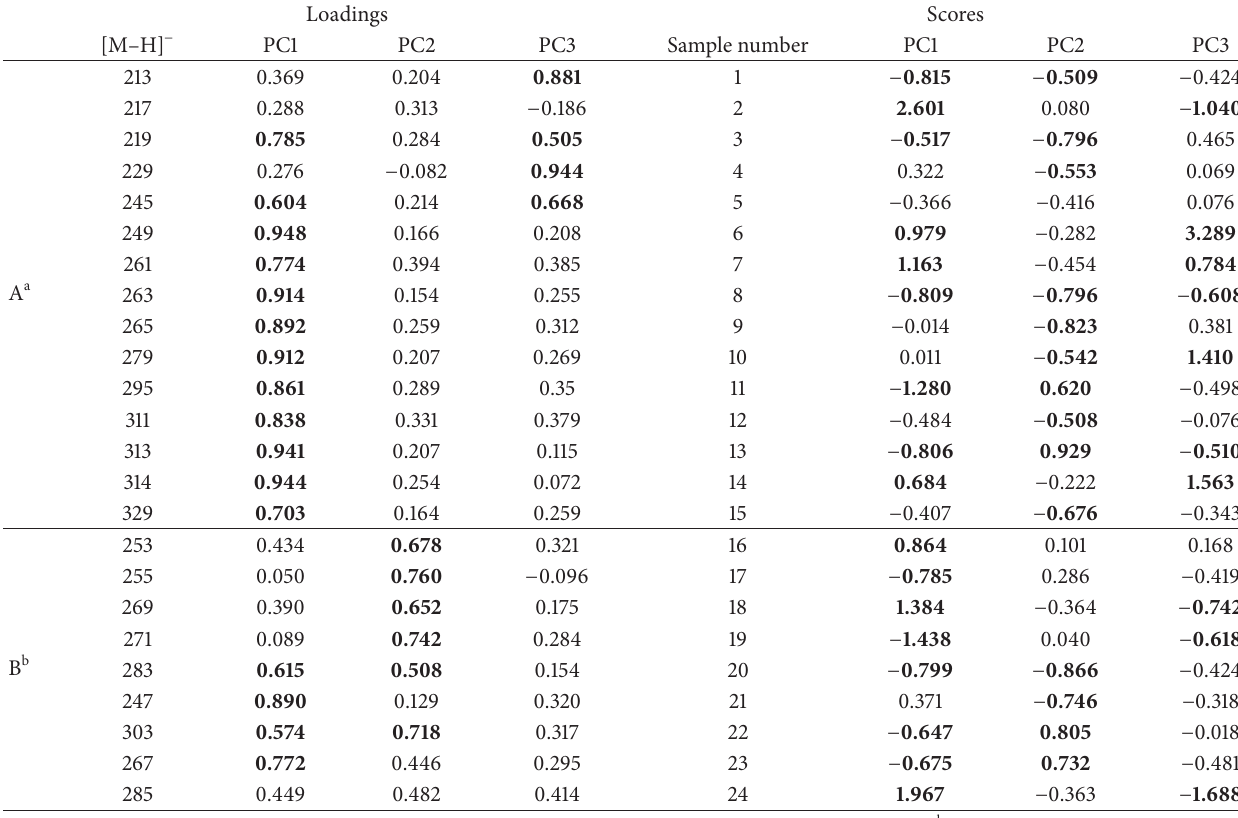
Table 3: The loadings and the scores for the first three rotated principal components.